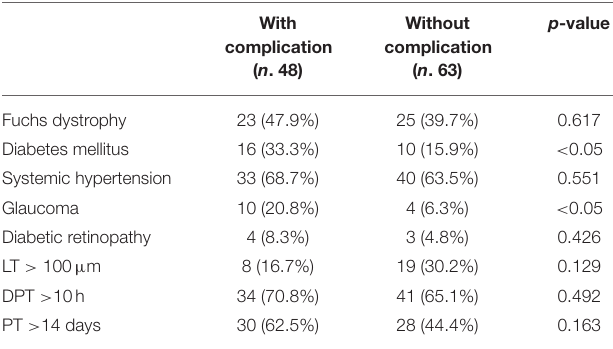
TABLE 6 | Correlation between post-operative complications and systemic, ocular and graft features at baseline. With